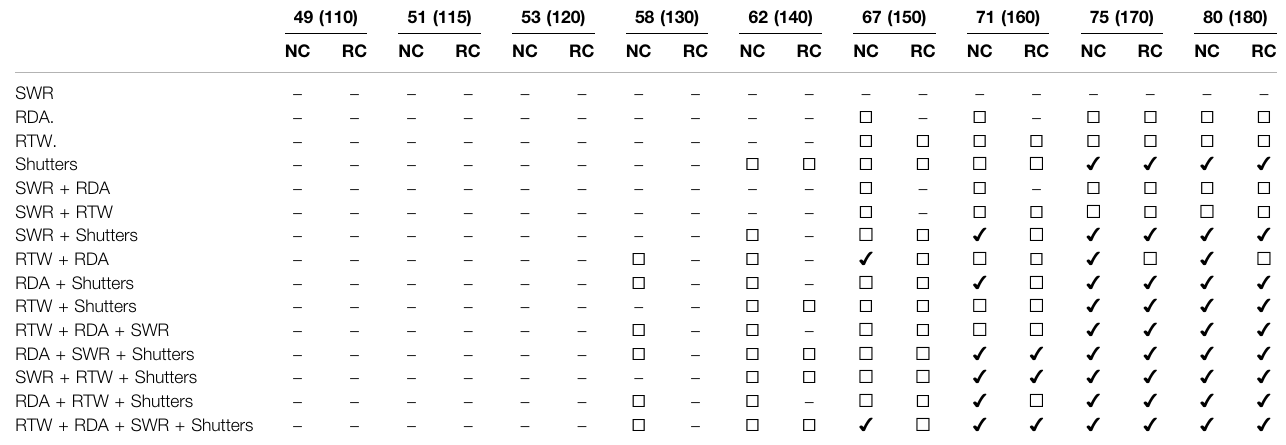
TABLE 6 | Mitigation recommendation by wind contour, m/s (mph), for new construction (NC) and retro fi t construction (RC), for a 30-year time